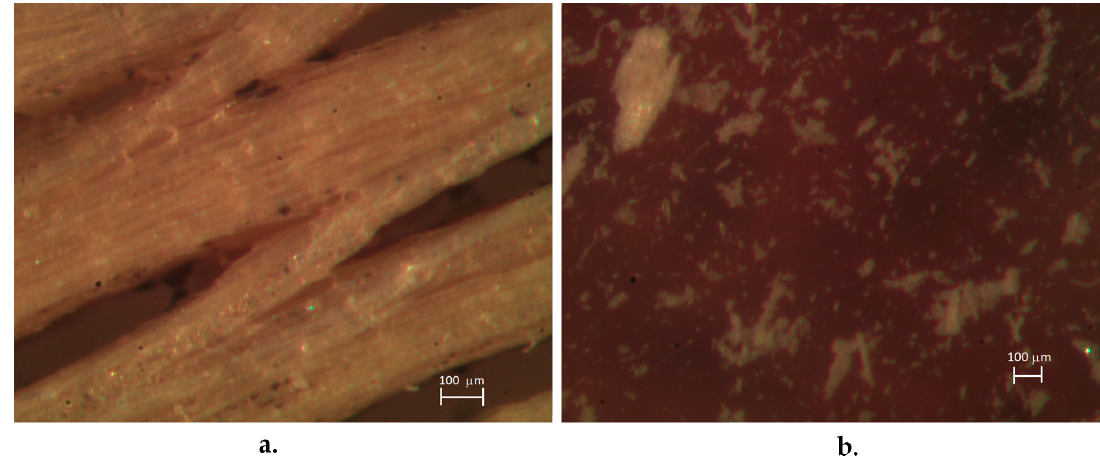
Figure 3. ( a ) Fibers as received after cleaning; ( b ) fibers after mashing in ball Figure 3 . ( a ) Fibers as received after cleaning; ( b ) fibers after mashing in ball mill . Table 1. Thickness of thermoplastic starch (TPS) and TPS–dry nopal fiber composites. Material